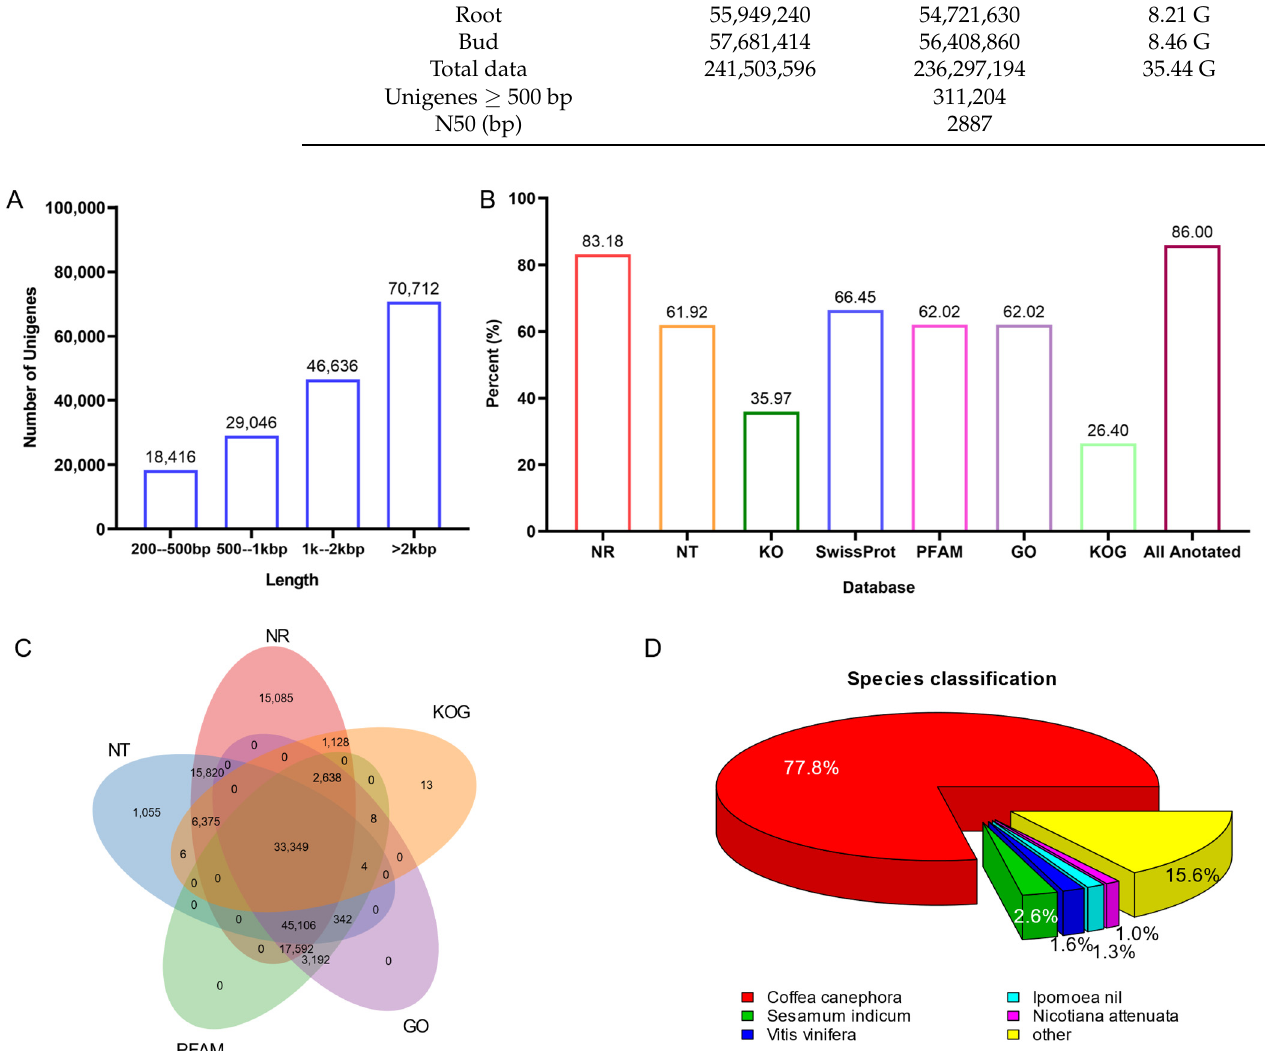
Figure 3. ( A ) the distribution of unigene length. ( B ) unigenes annotation by public databases. ( C ) Veen diagram of unigene annotation. ( D ) distribution of annotated species.